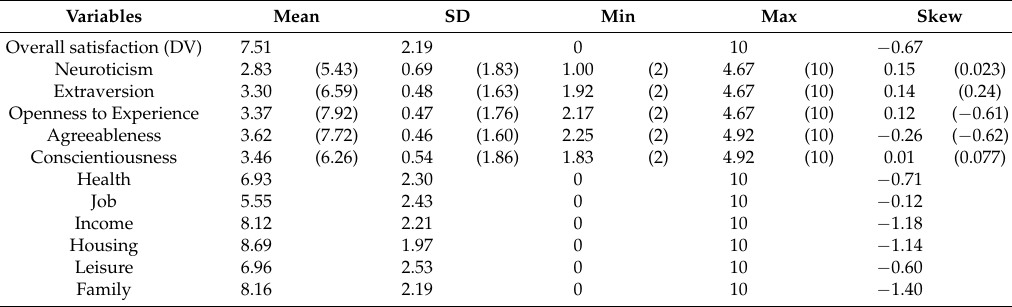
Table 10. Mean, standard deviation, minimum, maximum, and skew values of personality NEO-FFI (BFI-10) and satisfaction variables for Survey 4; DV = Dependent variable. ( N = 488). Variables Mean SD Min Max Skew Overall satisfaction (DV) 7.51